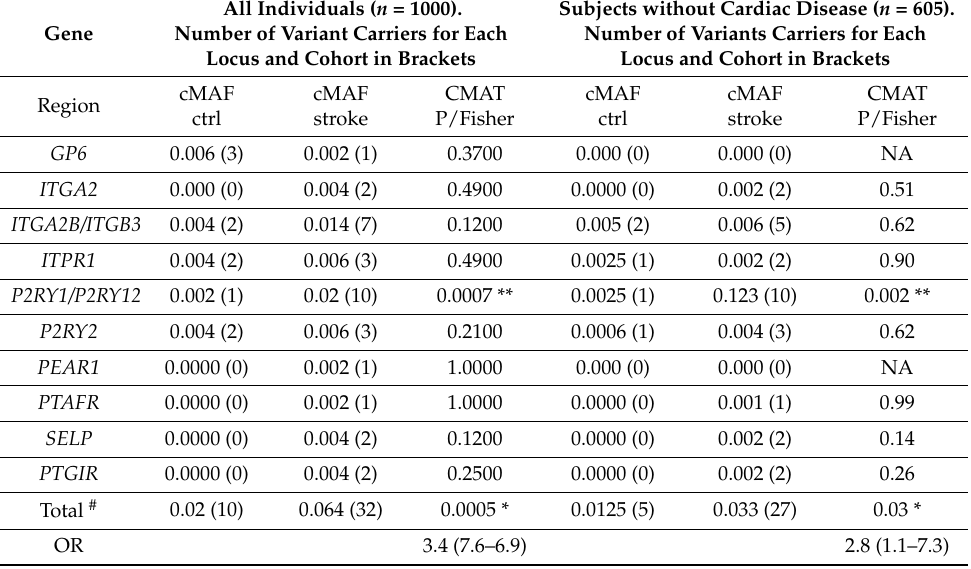
Table 2. List of cumulative minor allele frequencies (cMAF) for damaging non-synonymous variants in the individually genotyped subjects from the control (ctrl) and study (stroke) groups in all patients used for pooled sequencing (left panel) and remaining patients after subtracting cardiac conditions (right